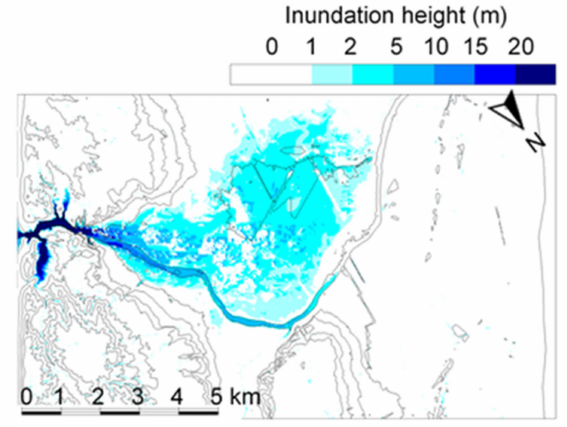
Figure 22. (Case–1). Inundation height, 30 min after start of the calculation.